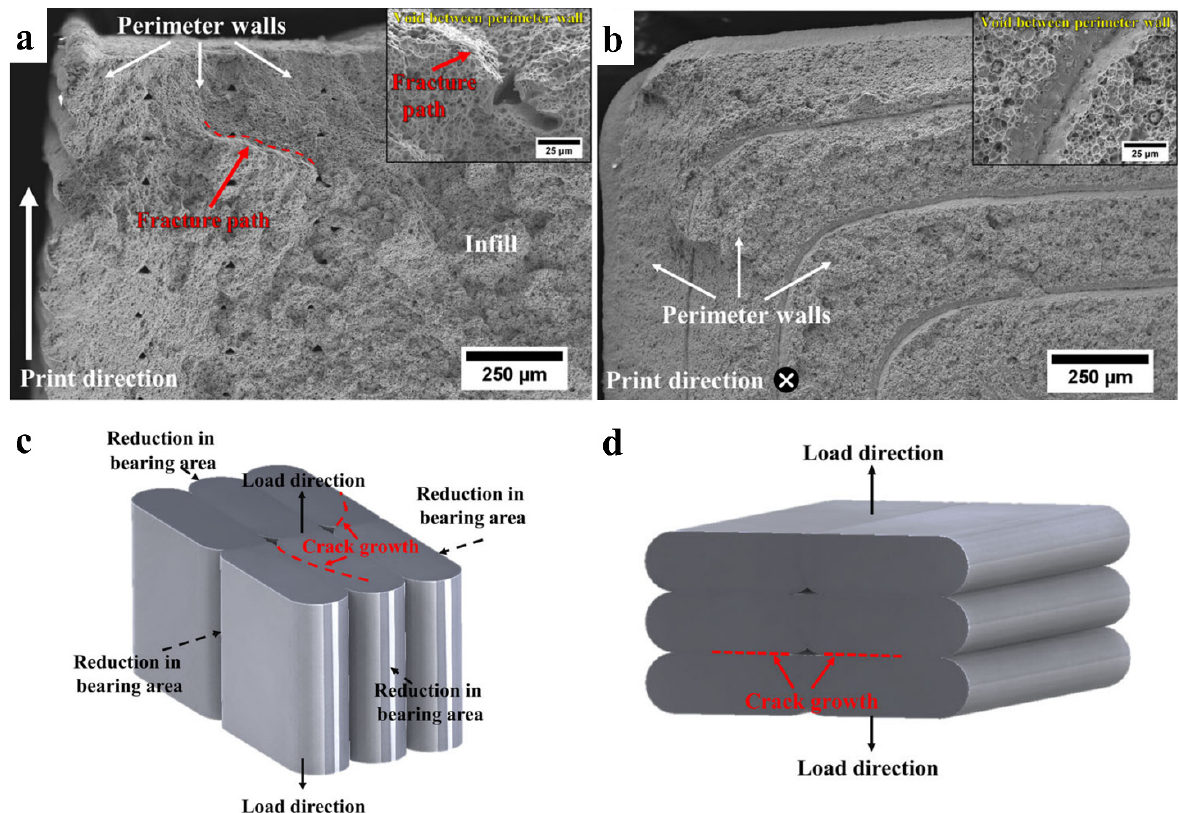
Figure 18. Fracture surface of metal MEX 17-4PH stainless steel specimens built with the ( a ) flat, ( b ) vertical orientations and schematics showing the failure mechanism of specimen built with the ( c ) flat and ( d ) vertical orientations (Reprinted with permission from [8]. Copyright 2021, Metallurgical and Materials Transactions A, Springer).